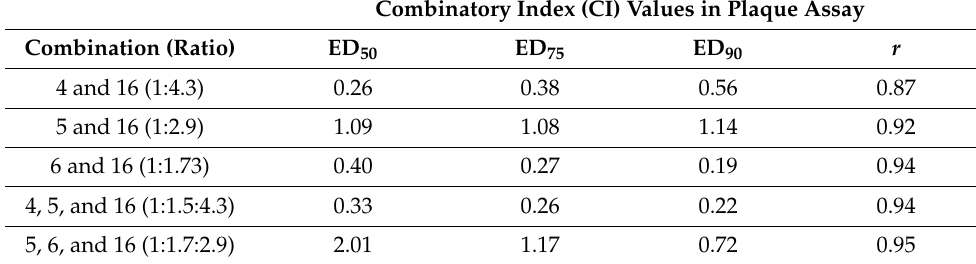
Figure 7. Compound 16 stabilizes HAdV capsid. The concentration used was 50 µ M. Data are representative of three experiments. Table 3. IC 50 values in a plaque assay for each derivative and its combination. Combination index value was calculated with CalcuSyn